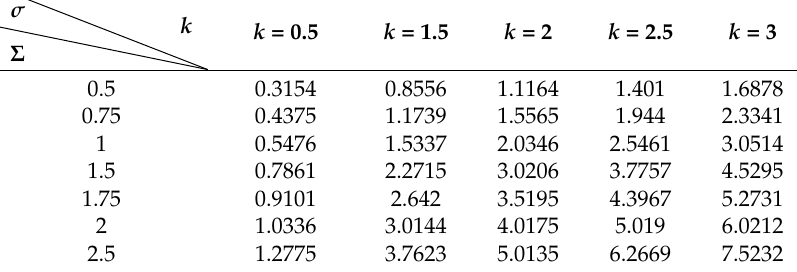
Figure 3. Relationship between the two parameters. Table 1 . Gaussian function parameters before and after scaling.